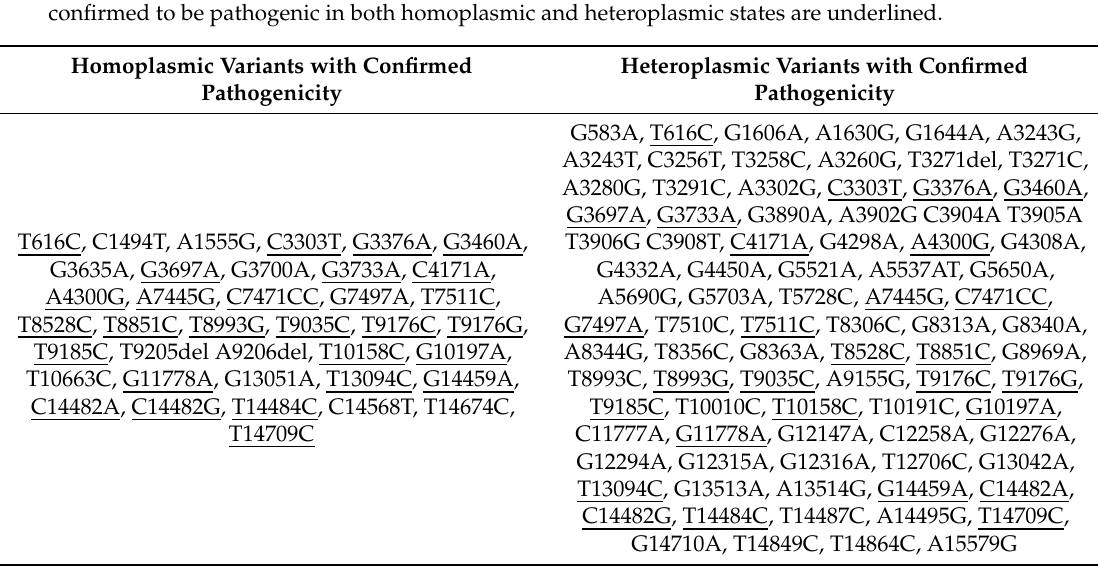
Table 1. List of the 92 confirmed pathogenic variants described in MitoMap [8], separated by homoplasmic state ( n = 37) or heteroplasmic state ( n = 83). Note that there are two multi-nucleotide variants a ff ecting multiple nucleotide positions: the dinucleotide deletion at T9205-A9206 and